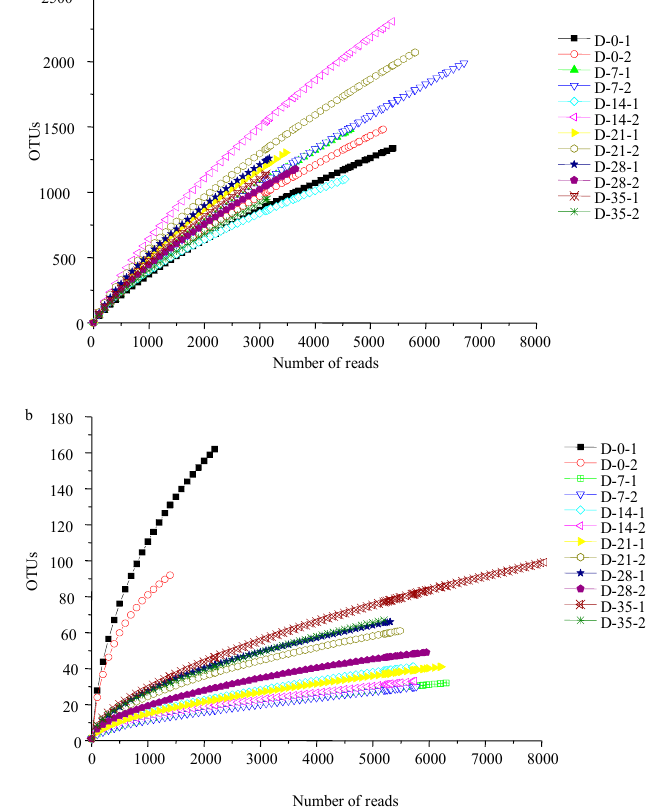
Figure 2. Rarefaction curve analyses of the 16S rRNA gene ( a ) and 18S rRNA gene ( b ) of the bacterial and fungal communities, respectively, present in the SSF of PFPT. Operational taxonomic units (OTUs) are defined as sequences sharing 97% nucleotide sequence similarity.